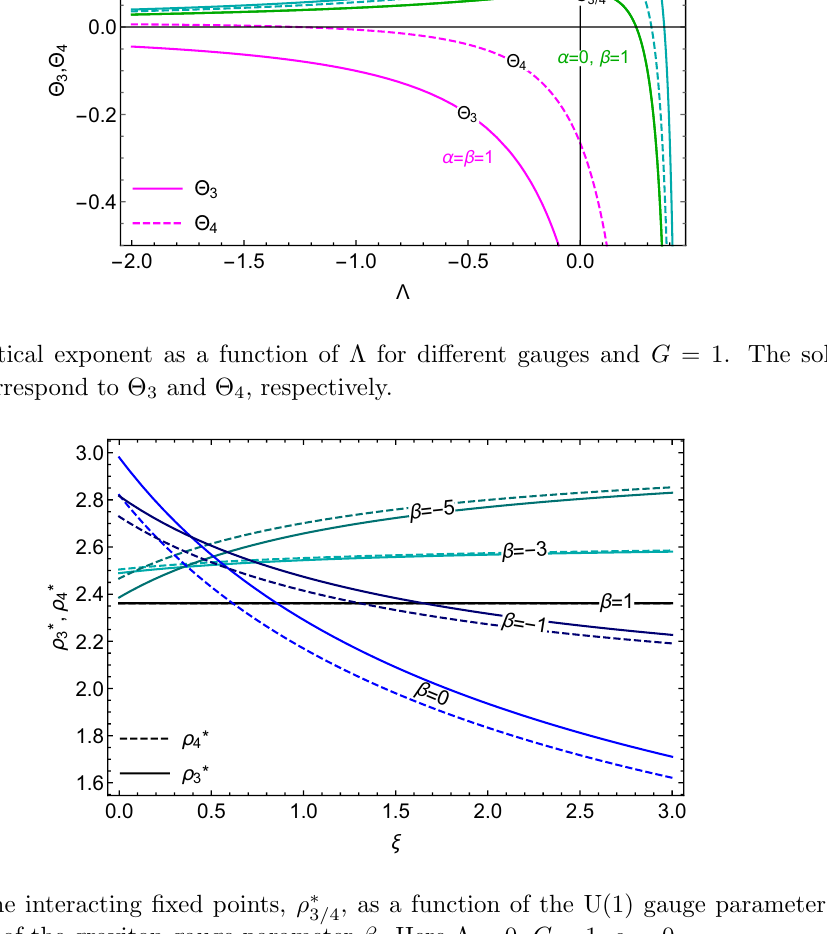
Figure 10 . The interacting (cid:12)xed points, (cid:26) (cid:3) , as a function of the U(1) gauge parameter, (cid:24) , for 3 = 4 di(cid:11)erent values of the graviton gauge parameter (cid:12) . Here (cid:3) = 0 ; G = 1 ; (cid:11) =